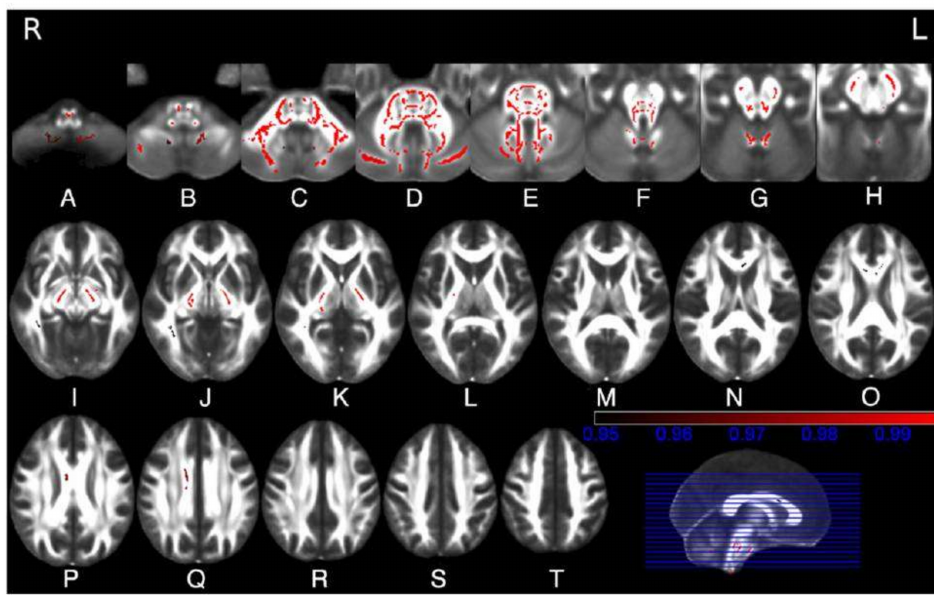
Figure 4. ( A – T ). Tract-basedspatial statistical analysis of di ff usion tensor imaging data in 10 SCA2 patients vs. 10 healthy controls. Maps show in red the clusters of significantly reduced fractional anisotropy in white matter tracts in the SCA2 patients. These include the inferior ( B , C ), middle ( C , D ) and superior ( E , F ) cerebellar peduncle, the cerebellar white matter ( C , D , E , F ), the medial and lateral lemnisci and the spinothalamic tracts ( D , E , F ), the transverse pontine fibres ( D , E ), the corticospinal tracts at the level of the internal capsule ( J , K , L ), cerebral peduncles ( G , H , I ), basis pontis ( C , D ) and bulbar pyramis ( A , B ), the corpus callosum ( N , O , P , Q ), the right inferior longitudinal fasciculus ( I , J ) and the inferior fronto-occipital fasciculus ( I , J ). Reproduced with permission from Della Nave R.,